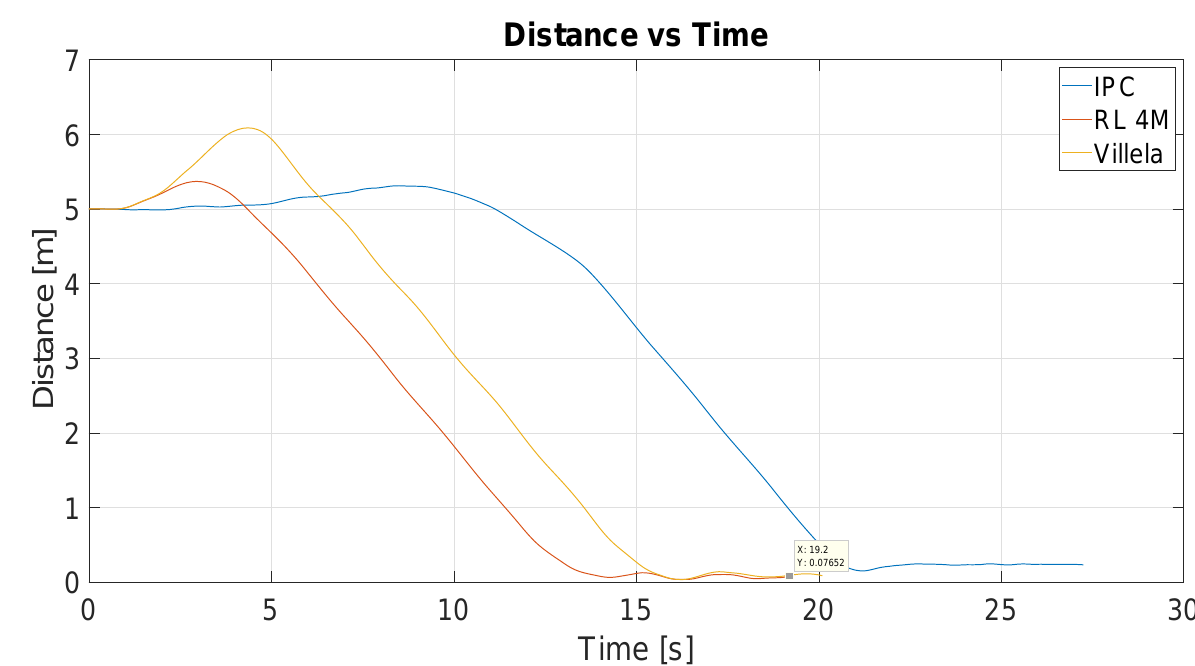
Figure 12. Distance vs. time of all experiences (RL, Villela and IPC).